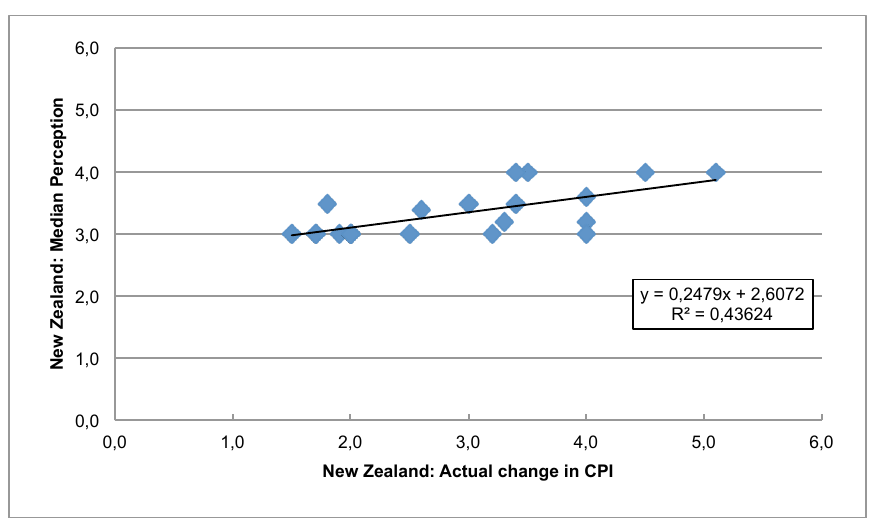
Graph 5: New Zealand Scatter plot of actual as opposed to perceived